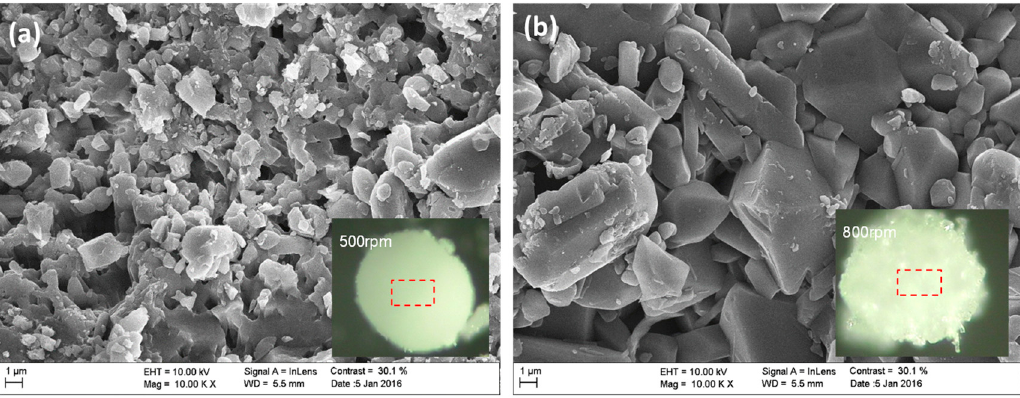
Figure 5. FE-SEM images, taken at 100,000× magnification, of CLP crystals obtained when IPA/Hex [40:60, v/v] was used as anti-solvent at a stirring speed of ( a ) 500 rpm and ( b ) 800 rpm at 35 °C .